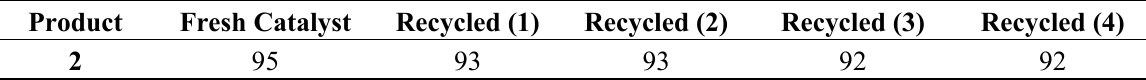
Table 1. Recyclability of the chitosan graft copolymer as basic